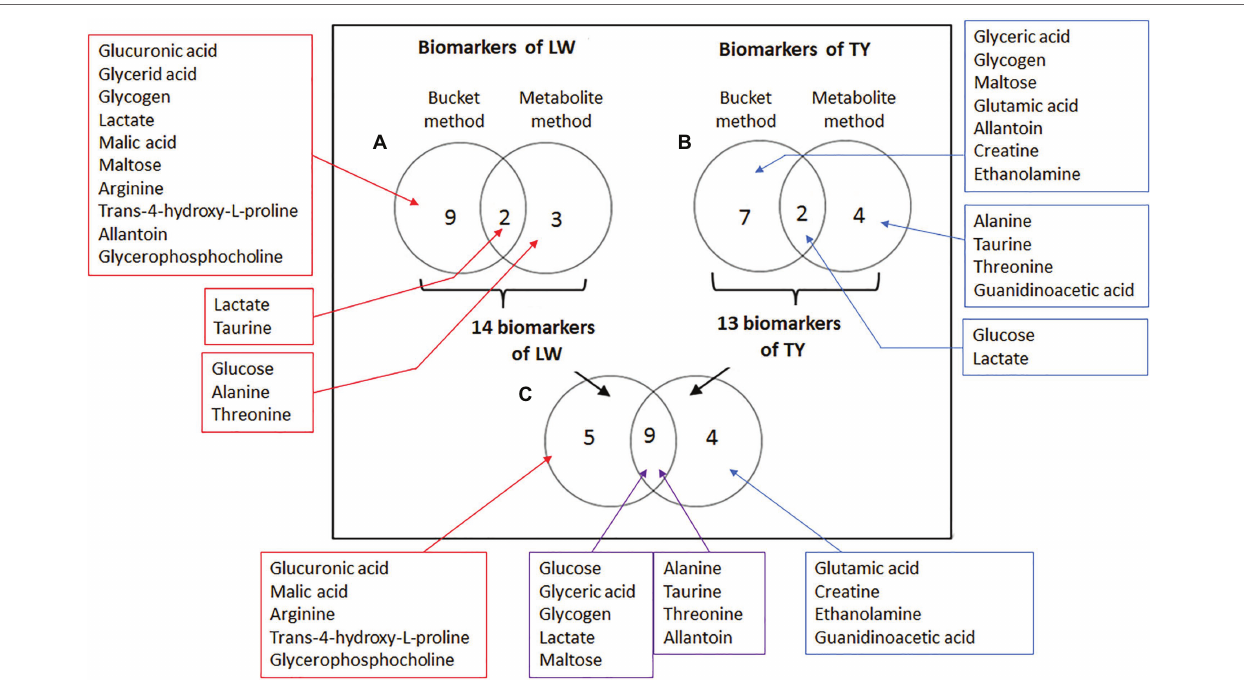
FIGURE 5 | Comparisons of biomarker lists with Venn diagram. (A) Biomarkers of liver weight identified by the bucket method and by the metabolite method (with VIP > 1 and BH p -value < 0.1). (B) Biomarkers of technological yield identified by the bucket method and by the metabolite method. (C) Biomarkers of liver weight and technological yield identified by at least one